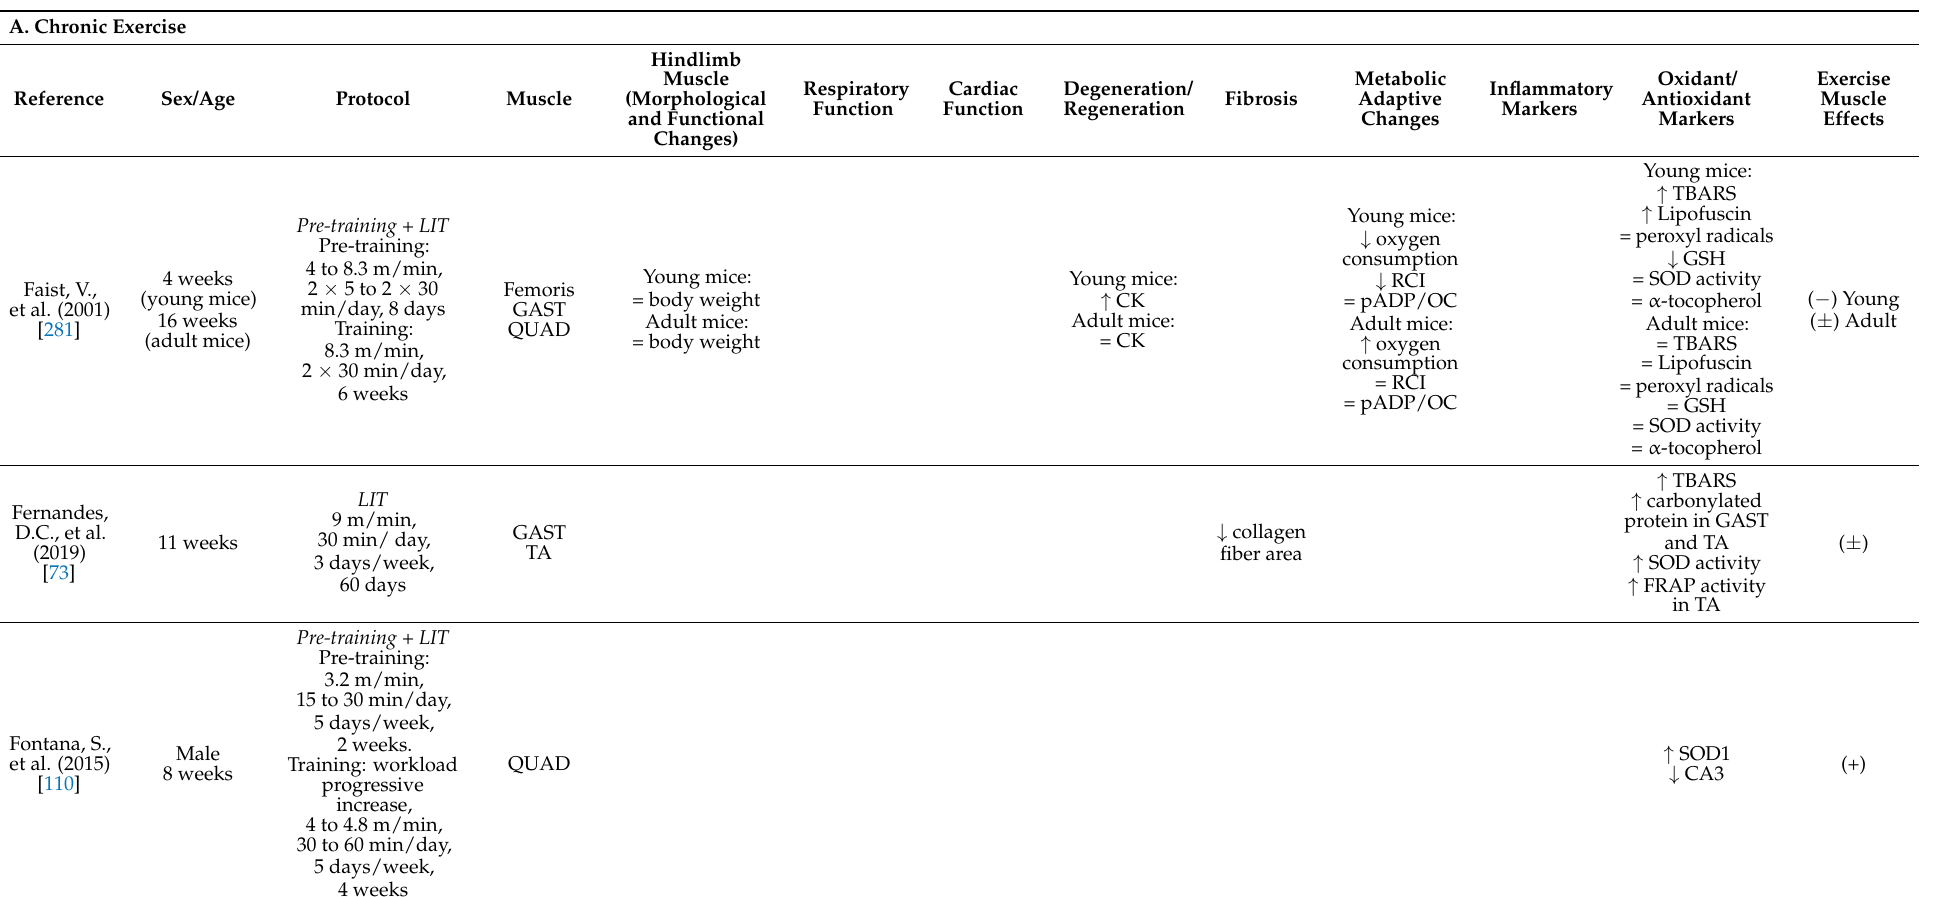
Table A1. Effects of treadmill running on mdx mouse